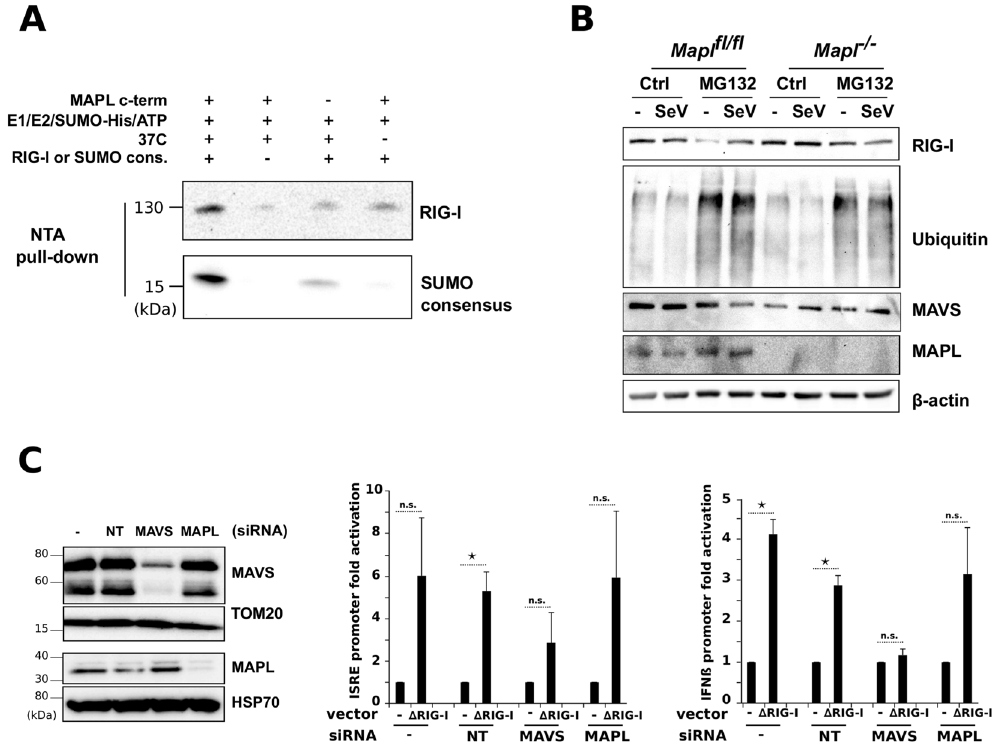
Figure 5. MAPL-dependent SUMOylation of RIG-I is required for activation. ( A ) In vitro SUMOylation assay. Recombinant RIG-I protein or SUMO consensus peptide were incubated in the indicated conditions. After the reaction, SUMO-conjugated proteins/peptides were isolated and immunoblotted. ( B ) Mapl fl/fl and Mapl − / − MEFs were incubated with MG132 (10 uM) and infected with SeV for 6 hrs then lysates were immunoblotted. ( C ) IFN β - and ISRE-luciferase reporter assays. U2OS cells were transfected with indicated siRNA for 48 hours then with pIFN β -luc or pISRE-luc reporter plasmid and pE-CFP (1 μ g each) together with 1 μ g of myc- Δ RIG-I (constitutively active form of RIG-I). Measures of luciferase activity and CFP were performed 21 hours post transfection. Data represents 2 different experiments done each time in triplicate. Values are reported as SEM ± mean. * P < 0.05, ** P < 0.01 and *** P < 0.001, n.s.,